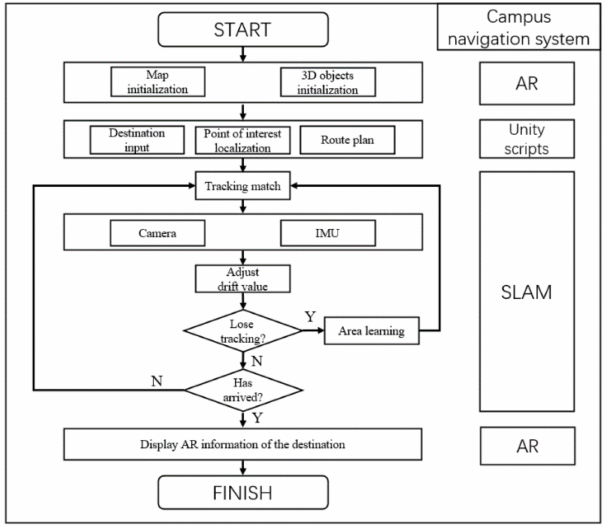
Figure 5. Logical structure of ARCore-based campus navigation